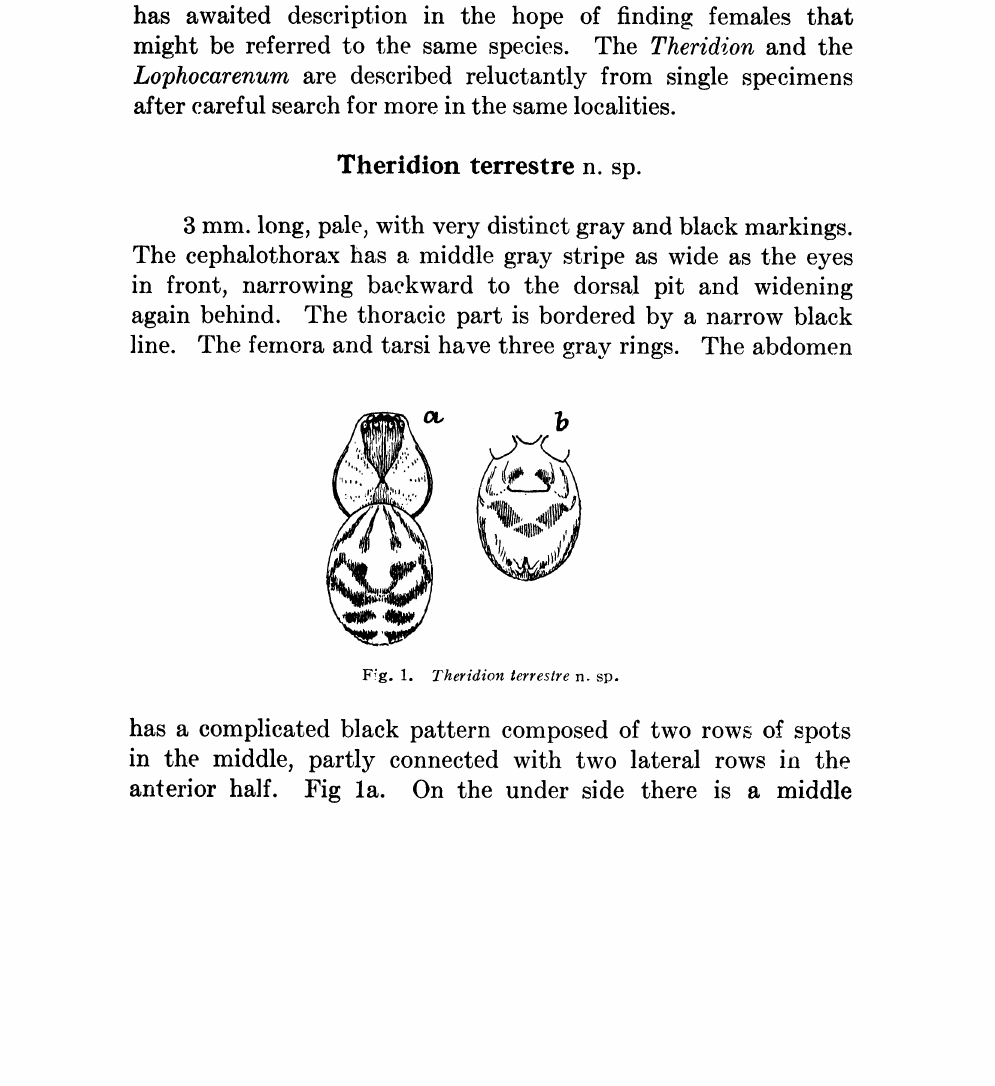
F!g. 1. Theridion terrestre